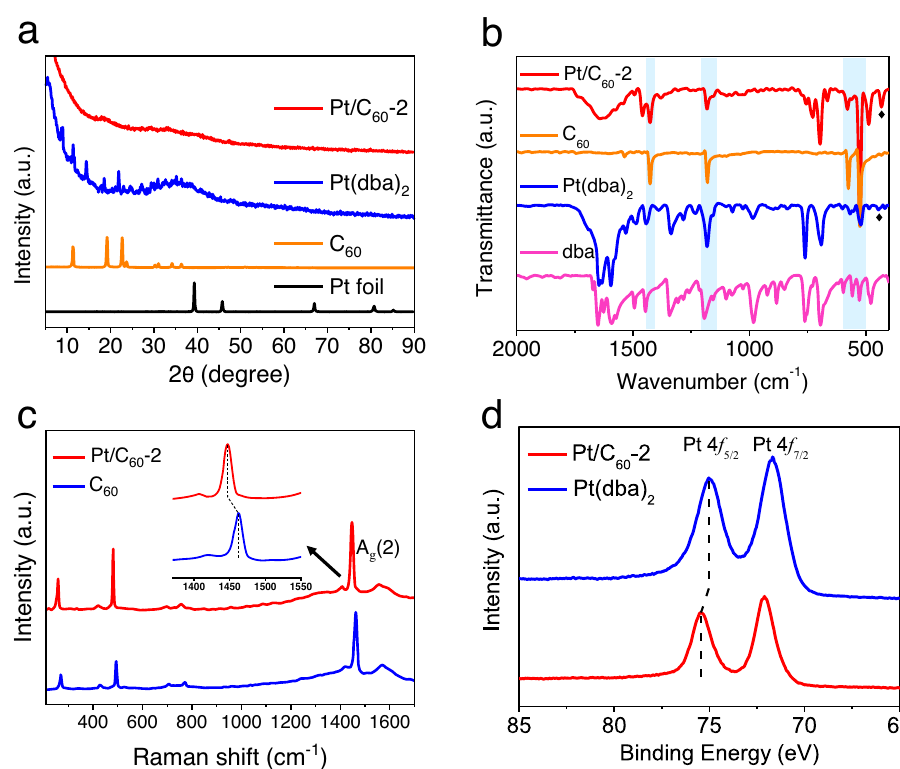
Fig.2|Spectraanalysis.a PXRDpatternsofPt/C 60 -2,Pt(dba) 2 ,C 60 andPtfoil. b IRspectraofPt/C 60 -2,C 60 ,Pt(dba) 2 ,anddba. c RamanspectraofPt/C 60 -2andC 60 . d High- resolution XPS Pt 4 f spectra of Pt/C 60 -2 and Pt(dba) 2